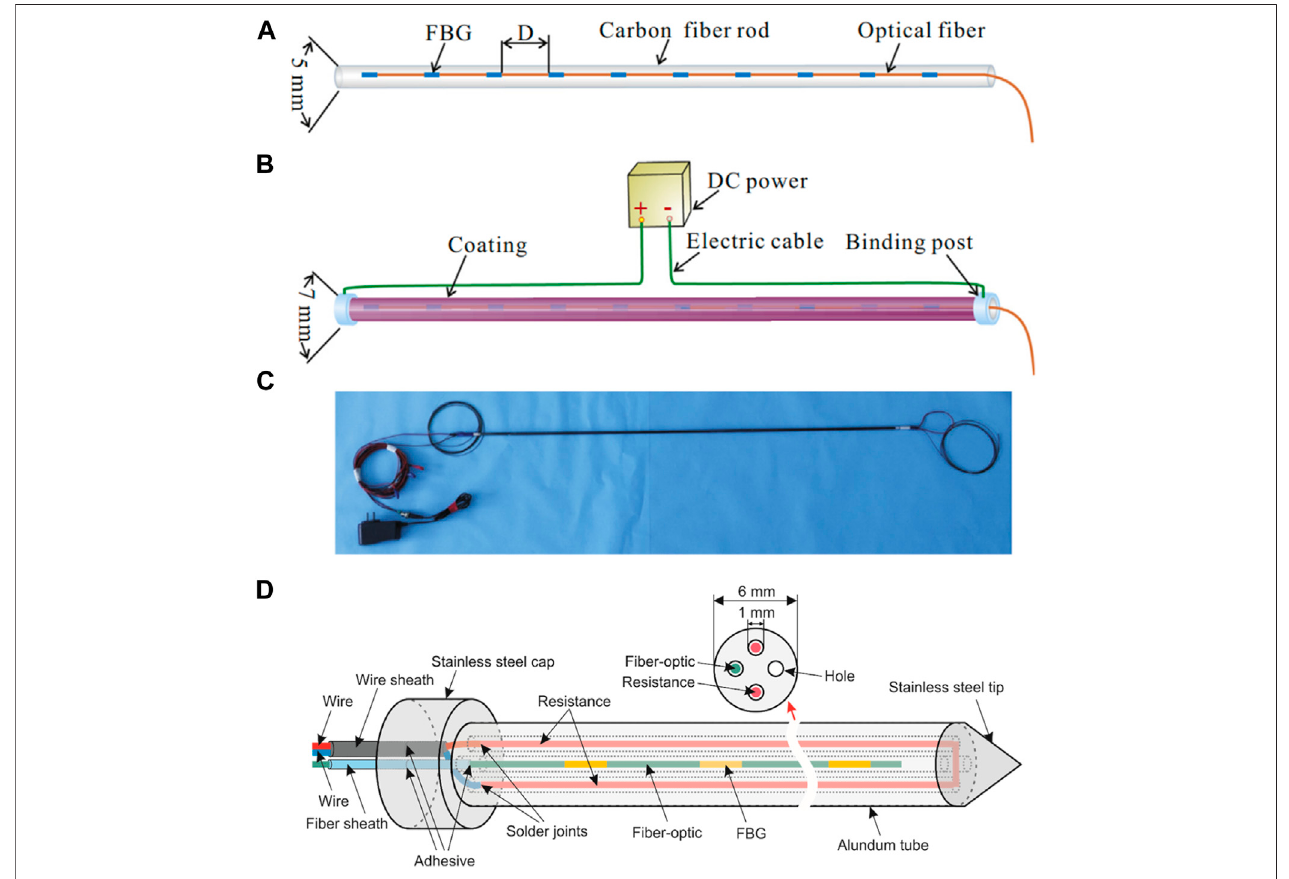
FIGURE 1 | Schematic diagram of CFHS and APHS. (A) Internal structure of the CFHS. (B) External structure of the CFHS. (C) Photo of the CFHS. (D) Internal structure of the APHS (Cao et al., 2018c; Sun et al., 2021).